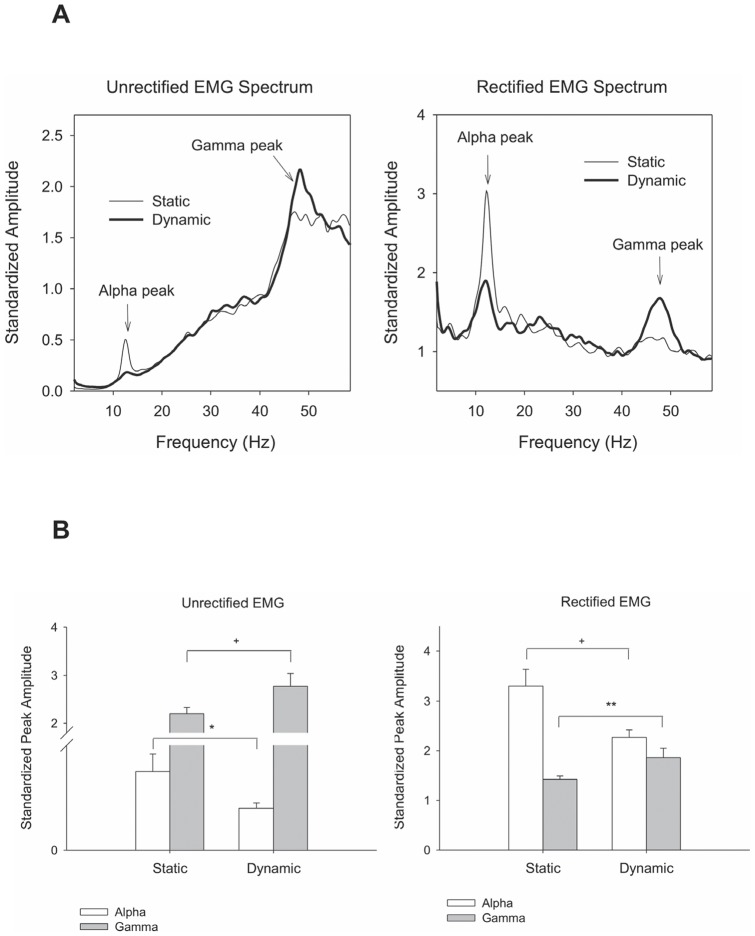
Contrasts of spectral features of the EMG between static and dynamic force-tracking.(A) Pooled spectral profiles of un-rectified and rectified EMG, (B) The means and standard errors of standardized amplitude for 8–12 Hz and 35–50 Hz spectral peaks. (Post-hoc test: *: Dynamic > Static, P<.05; ††: Static > Dynamic, P<.01; †: Static > Dynamic, P<.05).